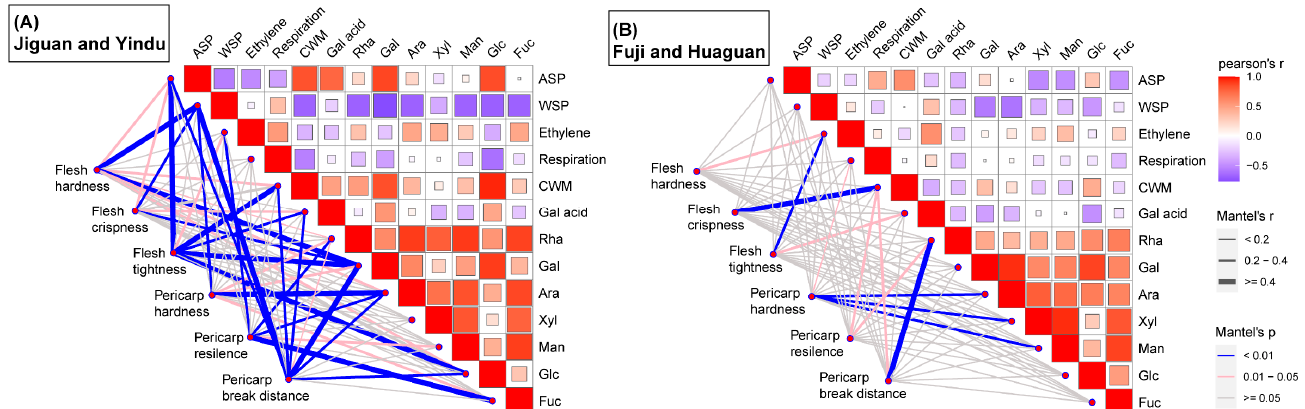
Figure 5. Correlation analysis for texture properties, physiological indicators of ‘Jiguan’ and ‘Yindu’ ( A ) and ‘Fuji’ and ‘Huaguan’ ( B ) apple fruits during postharvest. The Mantel test was used for the six texture properties and thirteen physiological indicators and Pearson for the thirteen physiological indicators. The size and color of the square represent the correlation coefficient of indicators for Pearson. The coarseness and color of the line represent the correlation coefficient of indicators for the Mantel test.